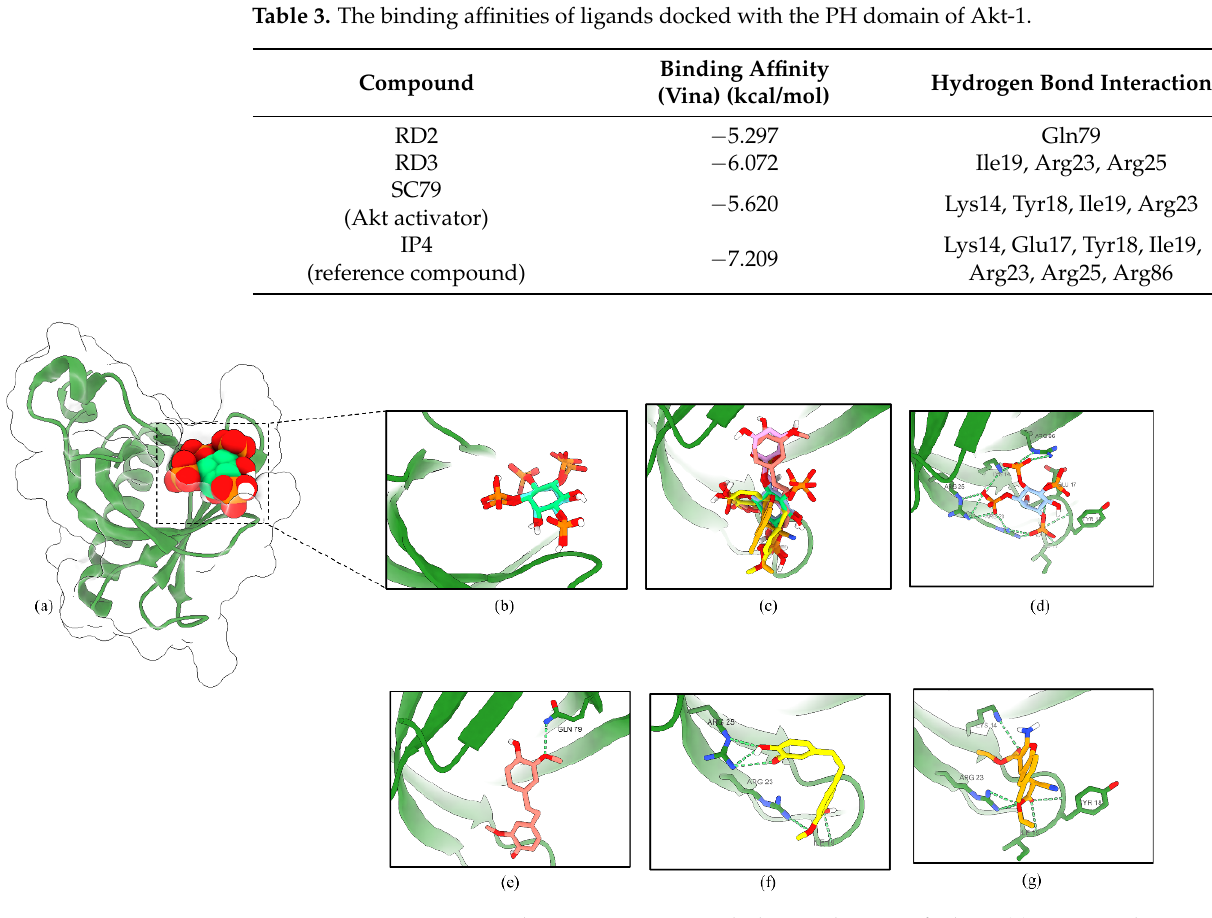
Figure 12. RD3 activates Akt via interaction with the PH domain of Akt-1. ( a ) Co-crystal structure of inositol (1,3,4,5)-tetrakisphosphate (IP4) in Akt-1 (PDB 1UNQ). ( b ) The original ligand (green) and redocking (blue). ( c ) Superimposition of IP4, RD2 (red), RD3 (yellow), and SC79 (orange). The binding mode of compounds IP4 ( d ), RD2 ( e ), RD3 ( f ), and SC79 ( g ) in the PH domain of Akt-1. The green dashed lines indicate hydrogen